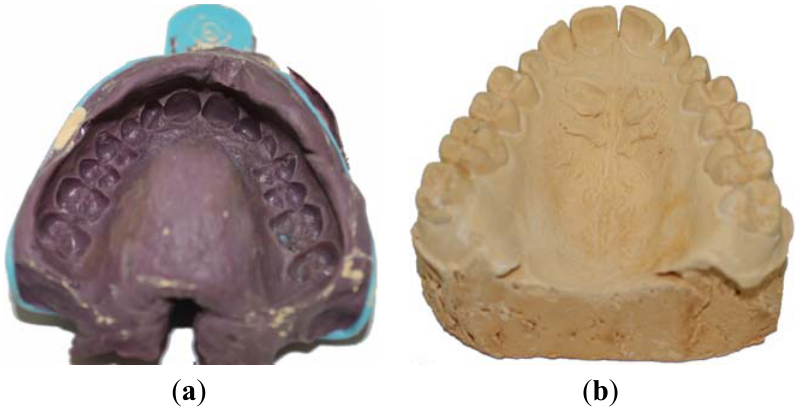
Figure 3. ( a ) Patient’s mouth impression. ( b ) Corresponding plaster cast.